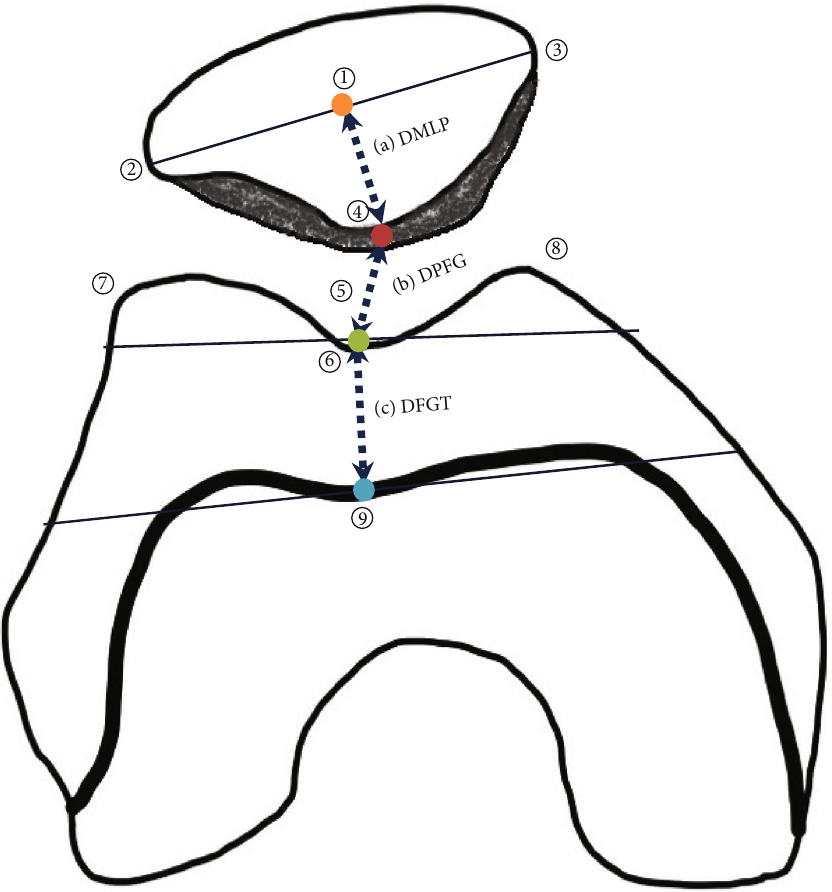
Figure 5: Measurement items ((1) patella, (2) lateral facet of patella, (3) medial facet of patella, (4) the lowest point of the median ridge of the patella, (5) patellofemoral joint space, (6) femoral trochlear groove, (7) lateral trochlear ridge, (8) medial trochlear ridge, and (9) tibial tuberosity). Table 1: Results of taking radiographic images at 70 ° to 20 ° by changing the knee fl exion angle at 10 ° intervals using Development of patellofemoral joint radiography auxiliary device (PJR). PJR used Measures Parameters Patellar angle X-ray tube